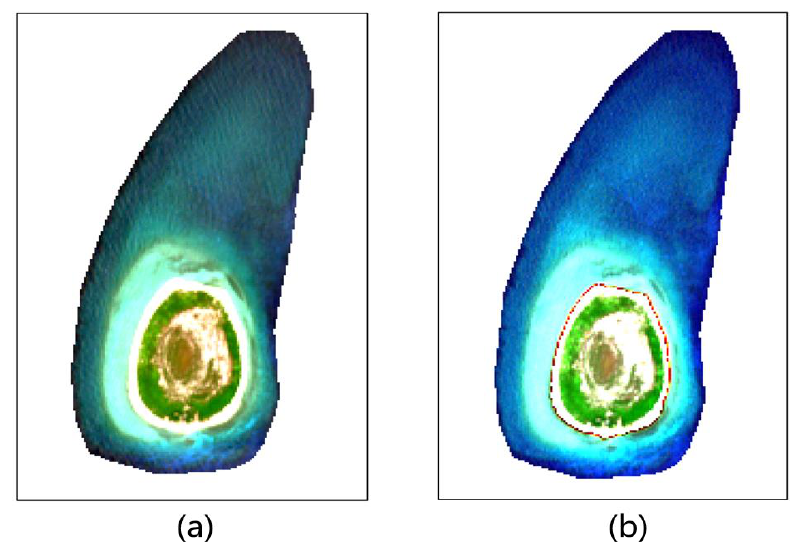
Figure 3. Comparison before ( a ) and after ( b ) sun-glint correction.